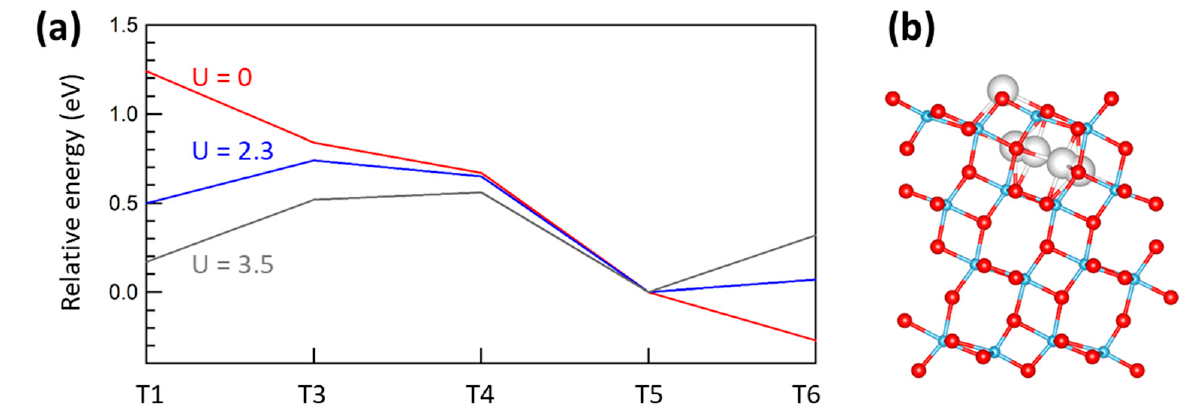
Figure 5. ( a ) Relative energy for an excess Ti atom at the a-TiO 2 (101) surface as a function of the occupied site, Tn. ( b ) Lateral view of the slab showing the positions of the examined interstitial sites as grey spheres. Colors are the same as in Figure 4. U values in eV.